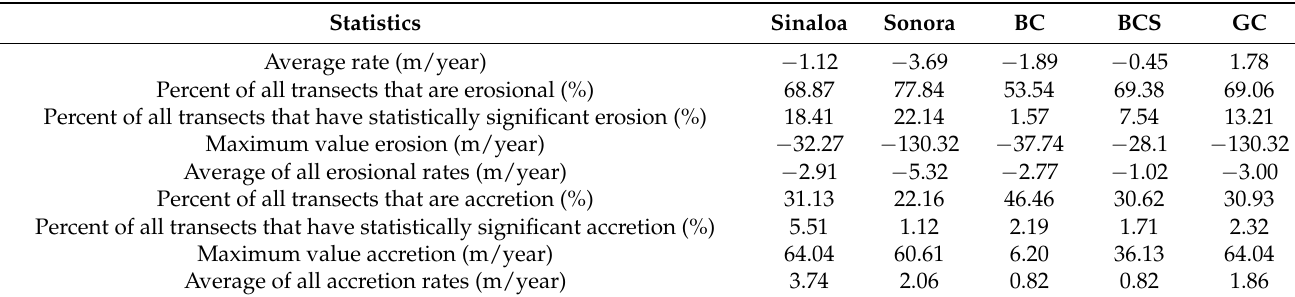
Table 5. Shoreline change rates by